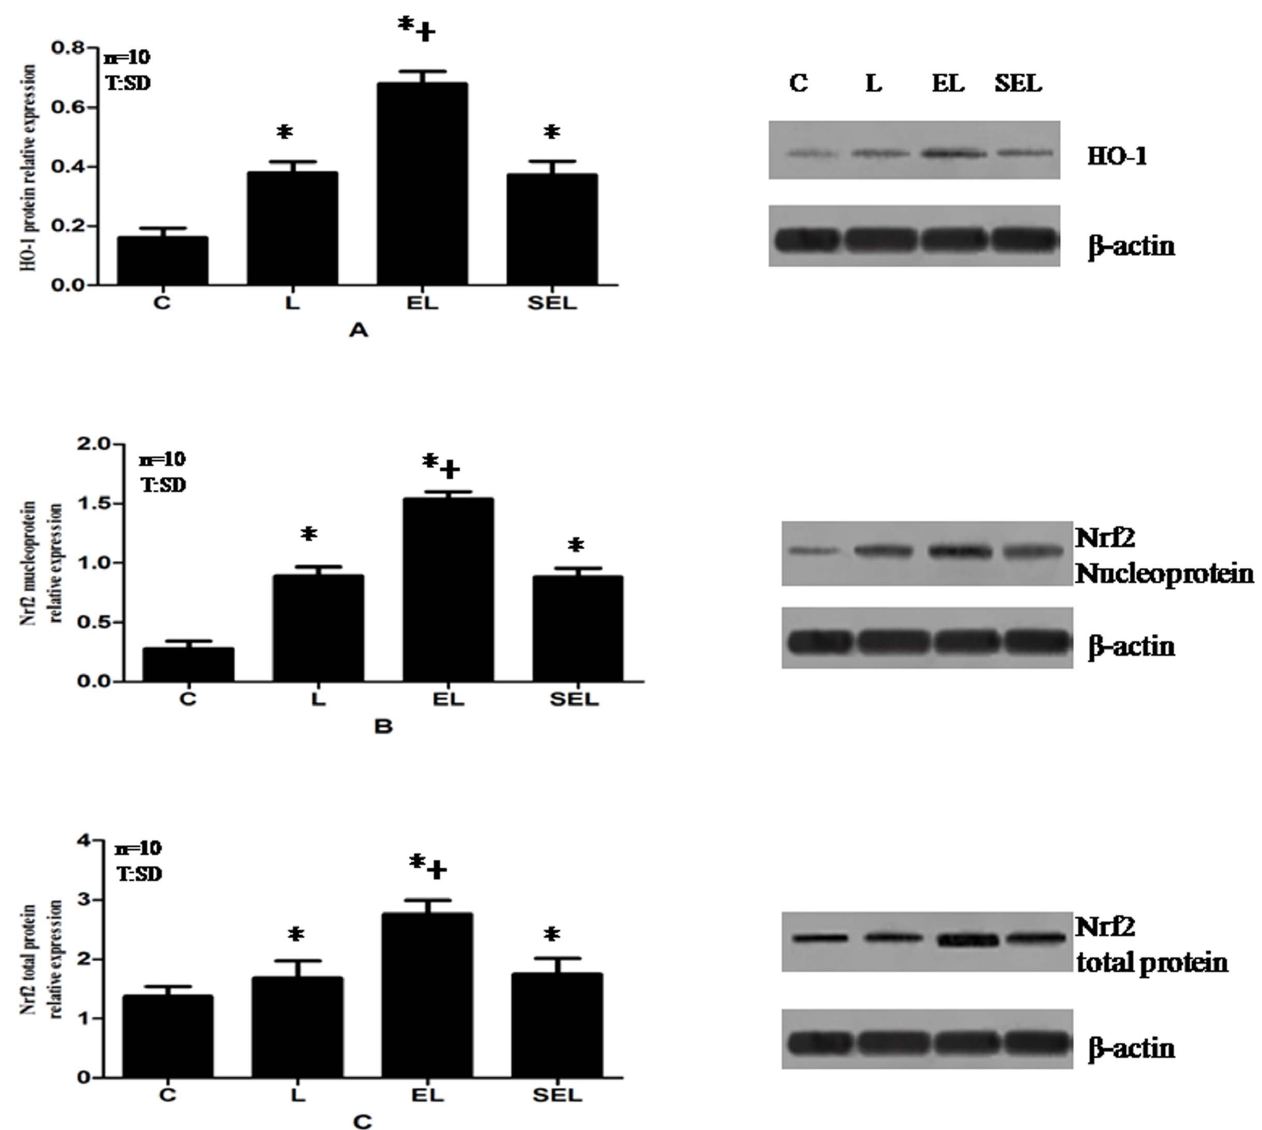
Figure 3. Western blot analysis of HO-1 protein (A), Nrf2 nucleoprotein (B) and Nrf2 total protein (C) relative expressions in lung tissue of four groups. Data were presented as mean 6 SD. ‘‘C’’ presents group C, ‘‘L’’ presents group LPS, ‘‘EL’’ presents group electroacupuncture + LPS and ‘‘SEL’’ presents group sham electroacupuncture + LPS. The expressions of HO-1 protein, Nrf2 nucleoprotein and total protein in group EL were higher compared with group C and group L ( P , 0.05 ). While sham electroacupuncture treatment exhibited the similar expressions of the above mentioned proteins to that of group L ( P . 0.05 ). Ten control, LPS, EL and SEL experiments were performed for each group. *P , 0.05 versus control group; + P , 0.05 versus LPS